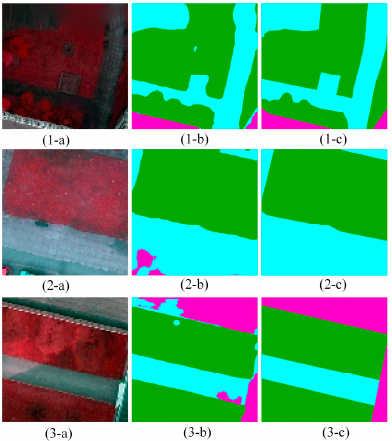
Figure 6. Examples of the performance of SRM CNN for di ff erent geo-objects: 1, 2, and 3 represent the patch number; and a, b, and c are the input coarse remote sensing images, predicted result, and reference, respectively.